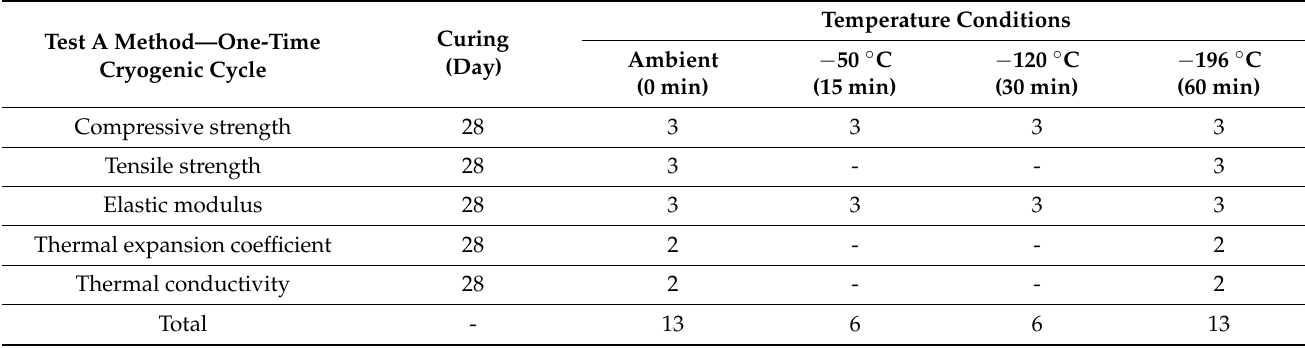
Table 9. Test method and concrete specimens under cryogenic condition.